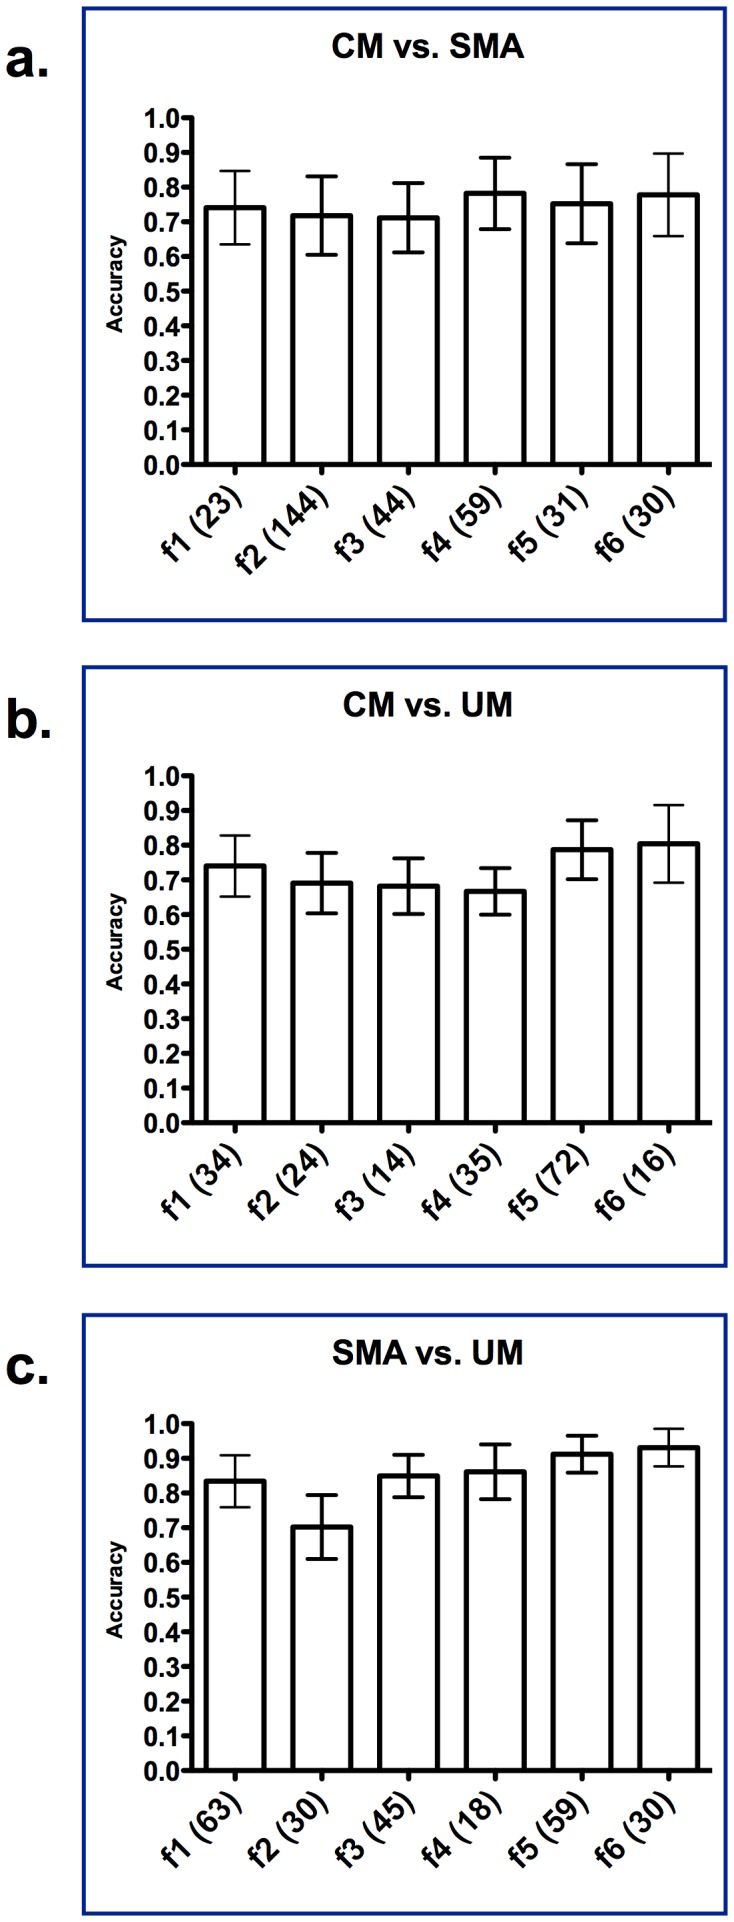
Discriminatory accuracy of proteome profiles across six anionic plasma fractions (f1 to f6) among CM, SMA and UM (all parasitemic) groups of children.CM = Cerebral Malaria; SMA = Severe Malarial Anemia; UM = Uncomplicated Malaria. f1 to f6 represent anionic plasma fractions at pH 9.0 (f1), pH 7.0 (f2), pH 5.0 (f3), pH 4.0 (f4), pH 3.0 (f5) and organic phase (f6). In brackets are shown the number of relevant m/z clusters that make up the discriminatory proteome profile. (a.) CM vs. SMA; (b.) CM vs. UM; (c.) SMA vs. UM.